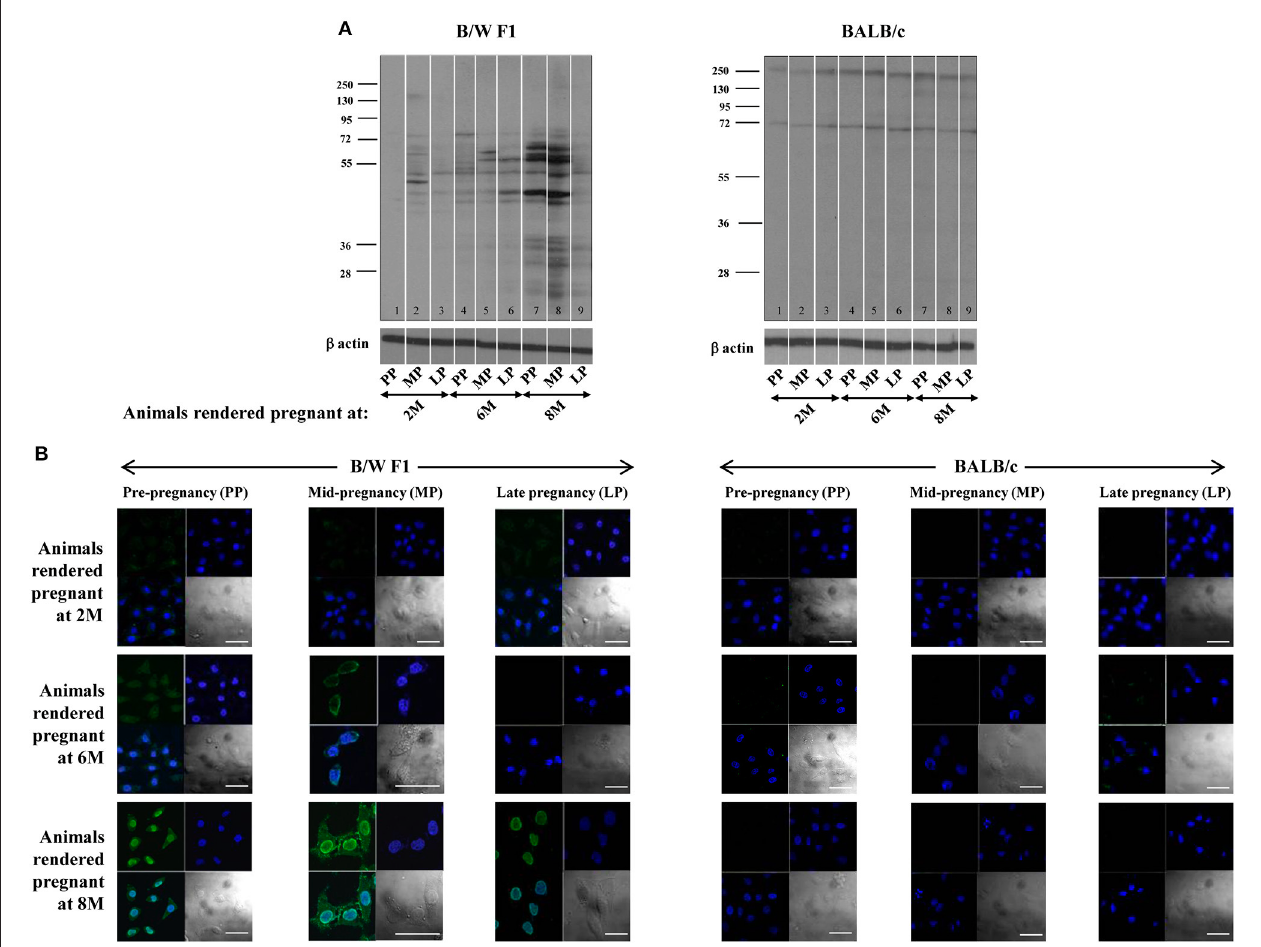
FIGURE 1 | Effect of pregnancy on humoral autoimmune responses. B/W F1 and BALB/c mice were rendered pregnant at 2 months (2M), 6 months (6M), and 8 months (8M) of age. (A) Western blot analysis of reactivity of antibodies in pooled sera [at pre-pregnancy (PP), mid-pregnancy (MP; Day 12), and late-pregnancy (LP; Day 19)] toward CCL131 cellular extracts. Anti- β actin antibodies were employed to verify equivalence of loading. (B) Confocal analysis. Reactivity toward HeLa cells of antibodies in pooled sera at pre-pregnancy (PP), mid-pregnancy (MP; Day 12), and late-pregnancy (LP; Day 19). Top right panels, DAPI; Top left panels, Antibody reactivity; Bottom left panel, Overlays; Bottom right panels, DIC. Bars: 20 µ